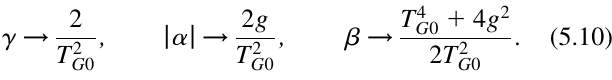
5 (cid:2) 10 (cid:1) 7 m , P 2 KW 0 ¼ 0 ¼ with T P